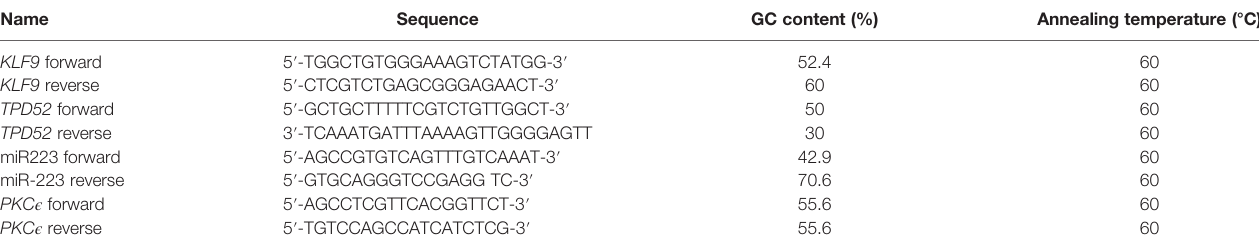
TABLE 1 | Sequences and parameters of primer used for